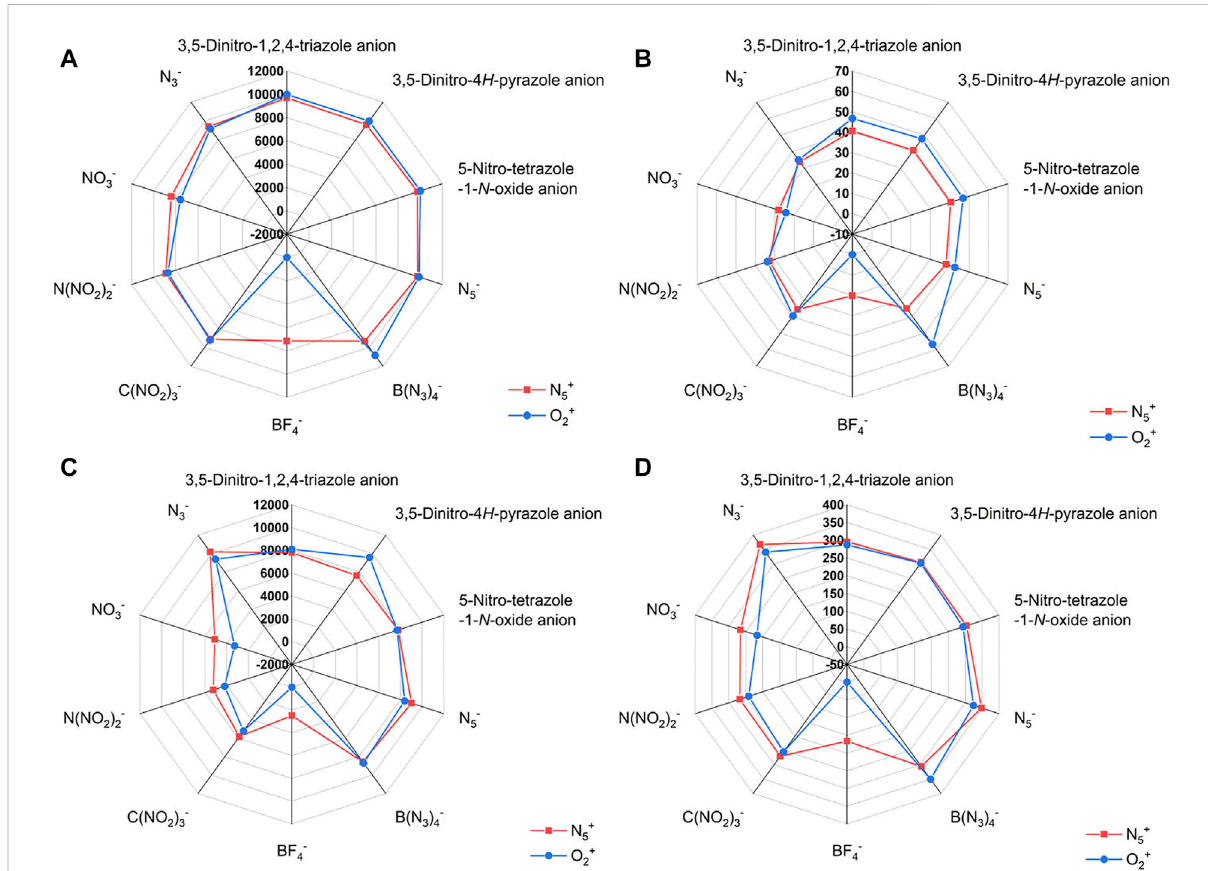
FIGURE 5 TheradarplotsoftheeffectofdifferentanionsonthedetonationparametersoftheN 5 + andO 2 + salts.The (A) isfor D , (B) isfor P , (C) isfor Q and (D) is for I sp ,